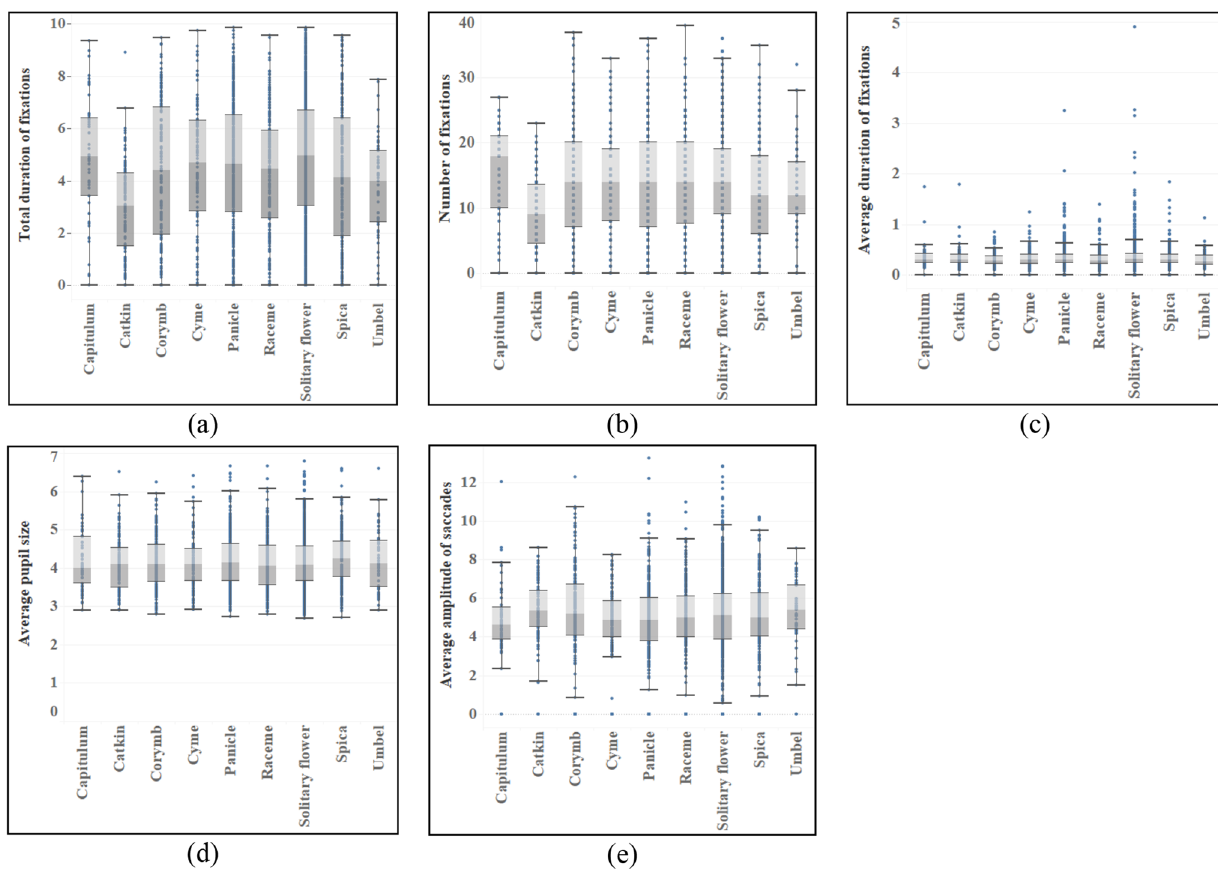
Figure 8. Eye movement indexes of different flower